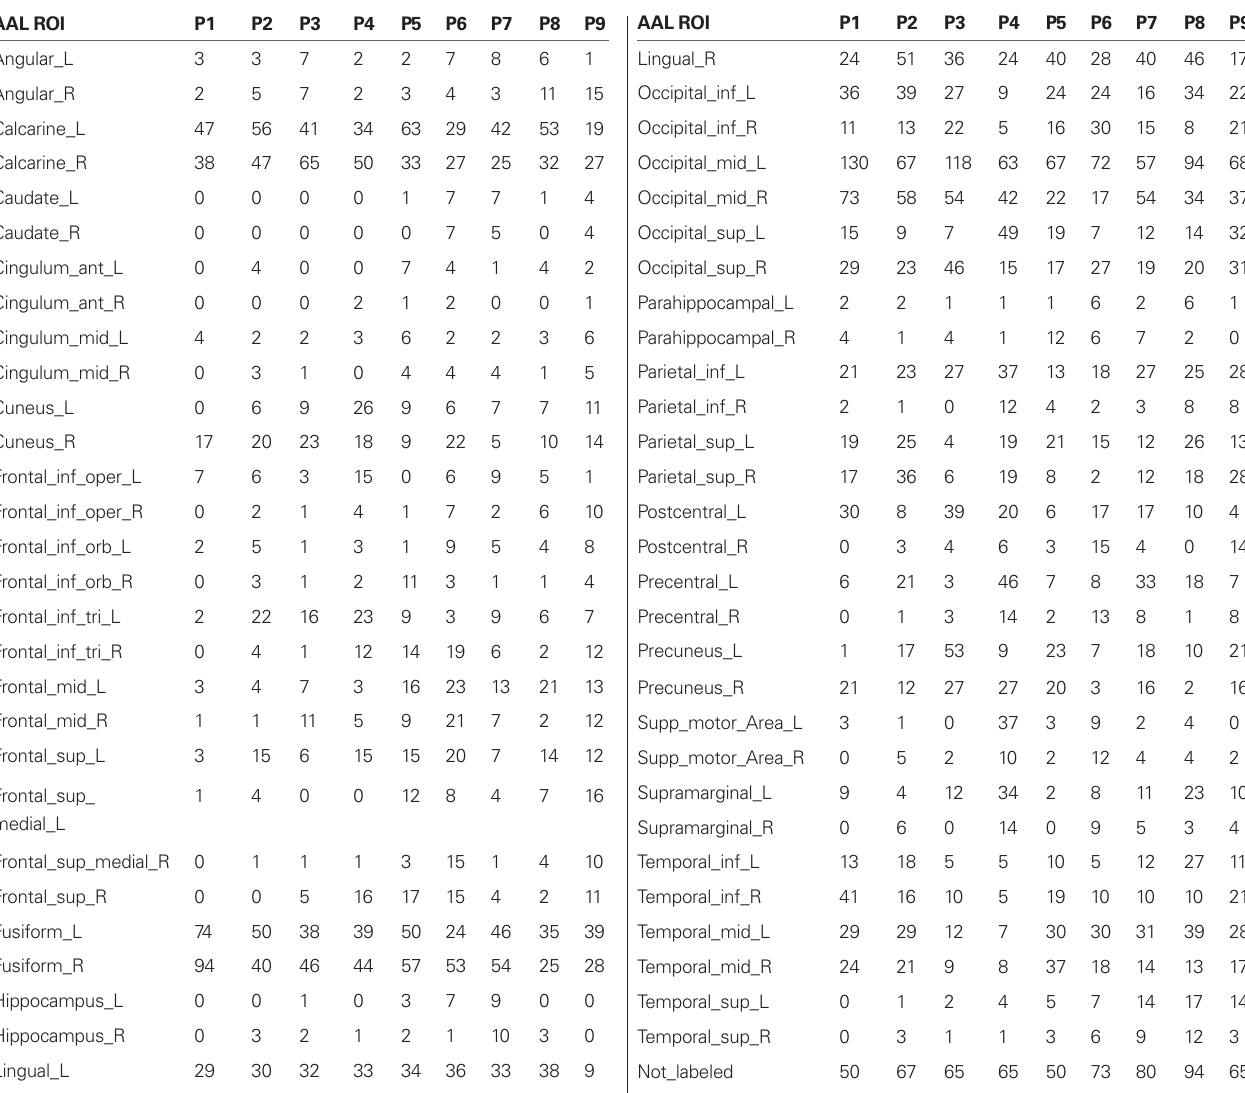
Table 2 | Average number of voxels selected from each cortical AAL ROI over all leave-two-out folds. AAL